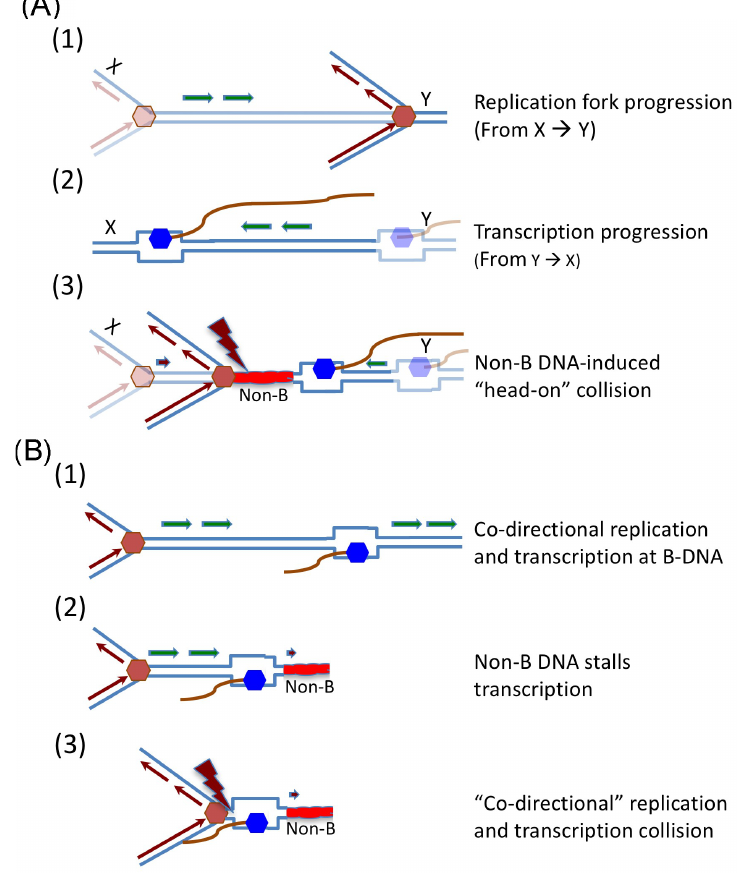
Figure 3. Models of non-B DNA-induced replication and transcription collision at repetitive regions. ( A ) Schematic diagram of non-B DNA-induced “head-on” replication-transcription collision. (1) DNA replication progresses from chromosome location “X” to “Y”; (2) Transcription progresses within the same region, but from the opposite direction (from “Y” to “X”) after (or before) DNA replication is complete in that area; (3) A non-B DNA structure formed between chromosome loci “X” and “Y” interrupts the initiation and/or progression of replication and transcription, resulting in “head-on” replication-transcription collision (shown as a lightning bolt). ( B ) Schematic diagram of non-B DNA-induced “co-directional” replication-transcription collision. (1) DNA replication and transcription occur simultaneously and “co-directionally” on the chromosome without collision; (2) A non-B DNA structure formed in front of the transcription machinery stalls transcription progression; (3) A DNA replication fork runs into the transcription machinery, resulting in a “co-directional” replication-transcription collision (shown as a lightning bolt).